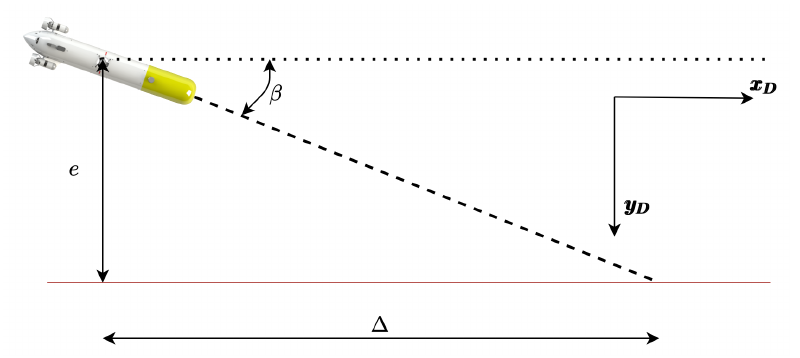
Figure 9. Beta concept representation.